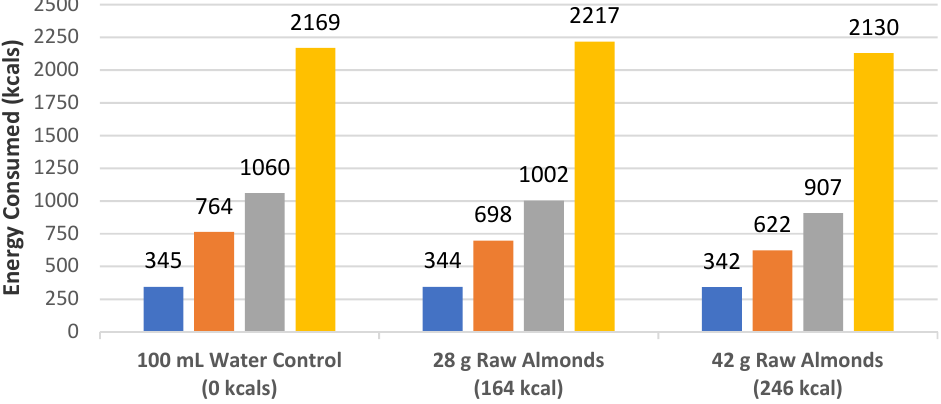
Figure 8. Dose–response effects of mid-morning raw almond snacking on subsequent meal energy intake, leading to an insignificant change in daily total energy intake compared to the water control in healthy women [7].